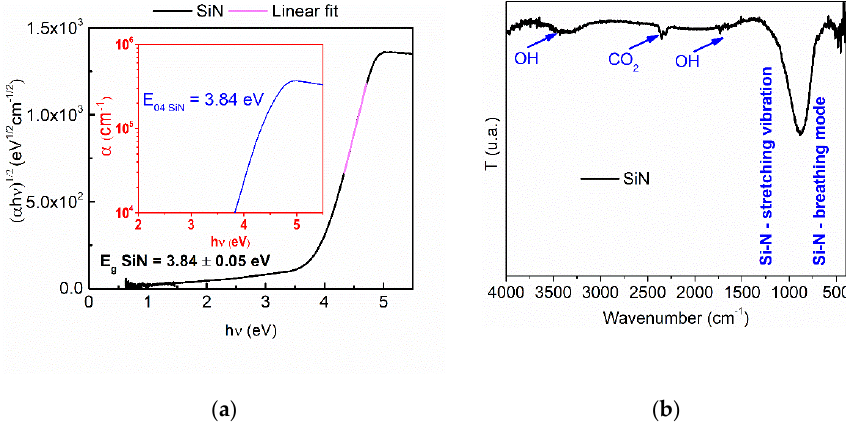
Figure 5. ( a ) Tauc plot for indirect band gap of SiN x monolayer with photon energy dependence of absorption coefficient (E 04 = f (h ν )—inset) and ( b ) FT-IR transmission spectrum of SiN x film.